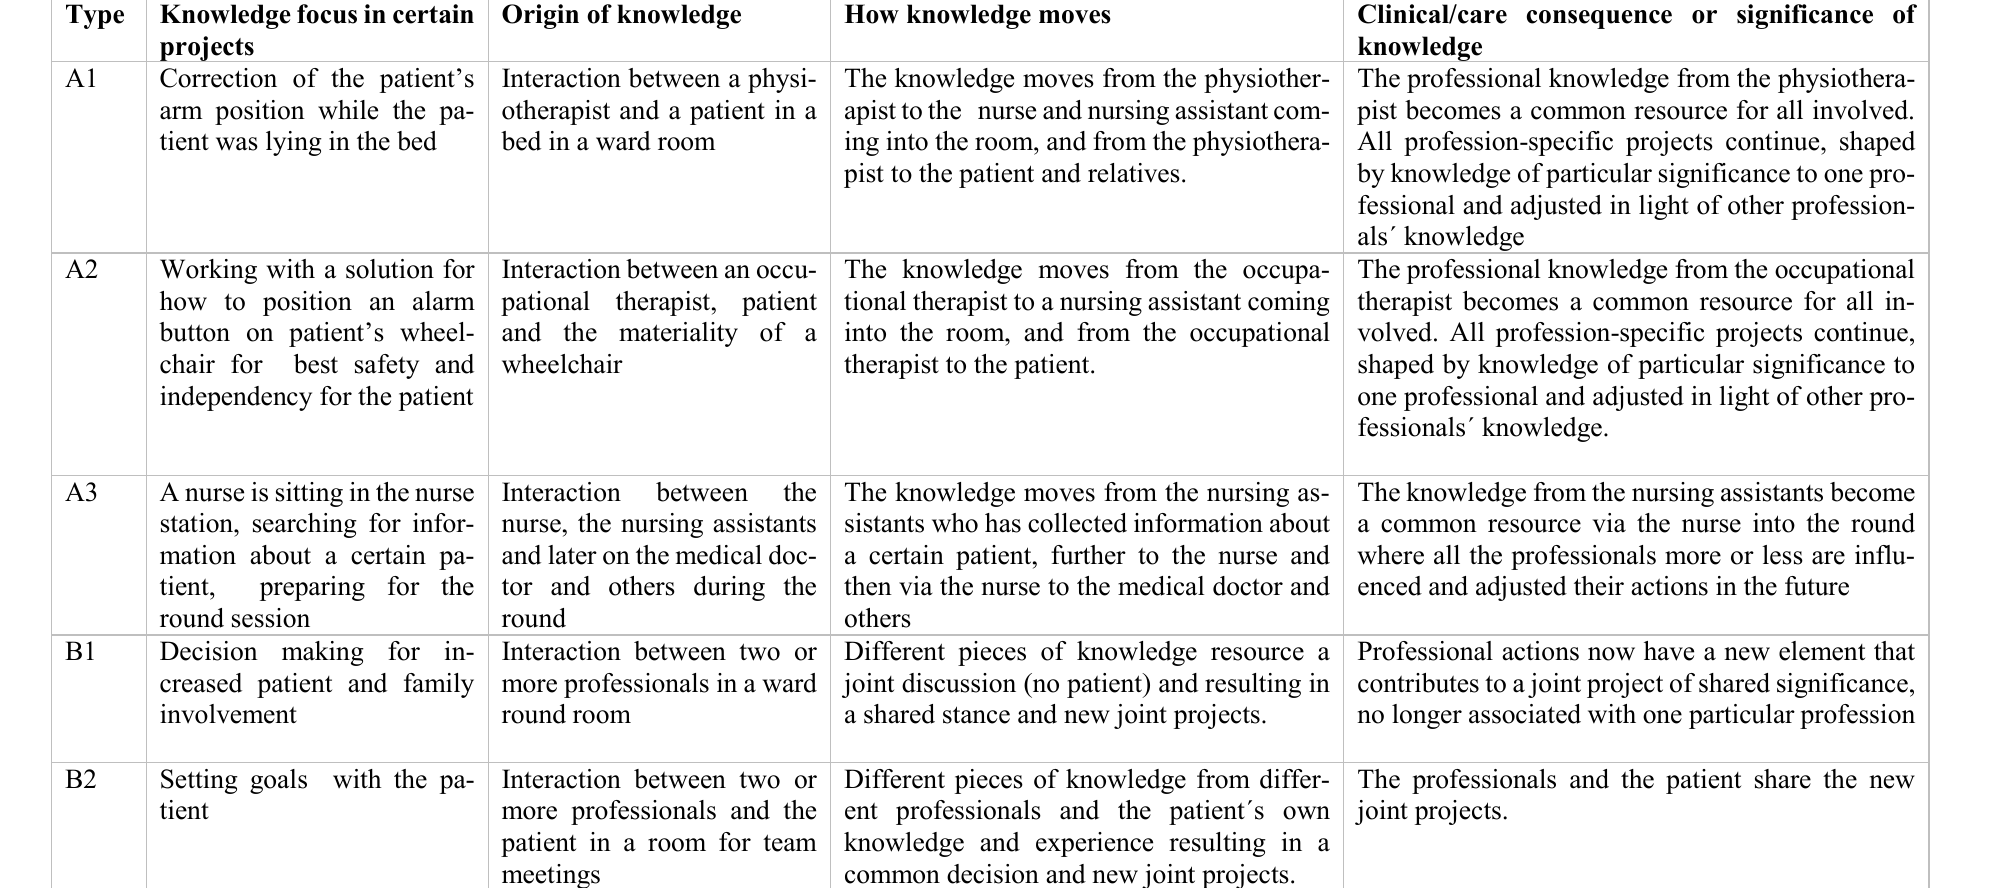
Table 1. Template with examples of patterns of how different professional practices hang together and how knowledge was shared in different projects of a practice (A—Orchestration, B—Communality, using Schatzki´s concept,